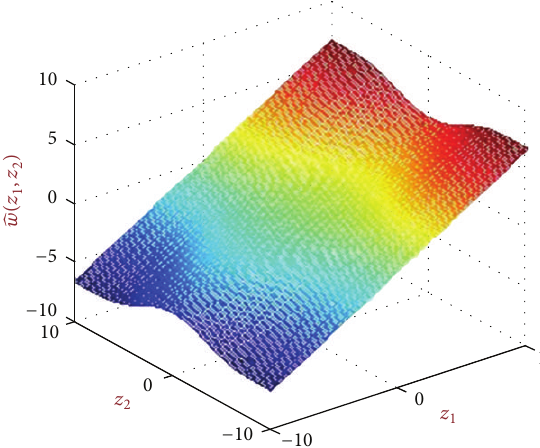
Figure 4: A shrinkage function produced from BiGaussMixShrink for sample